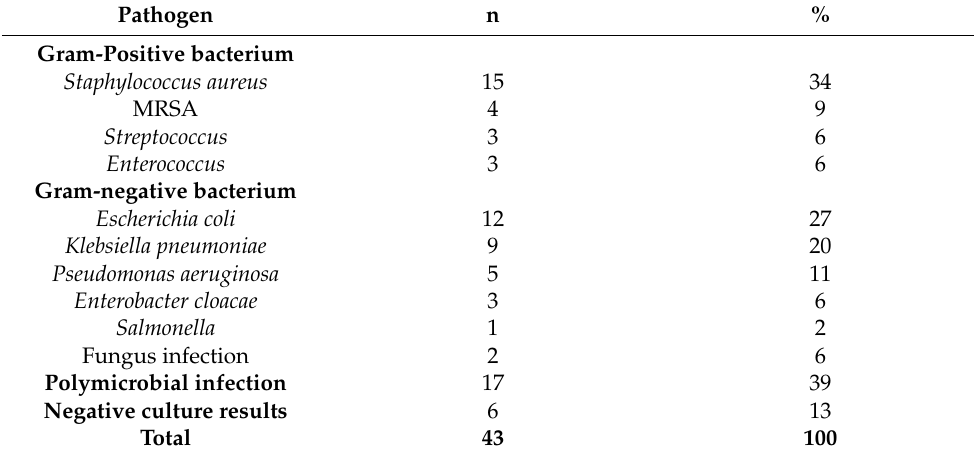
Table 3. Patients’ microbiological culture